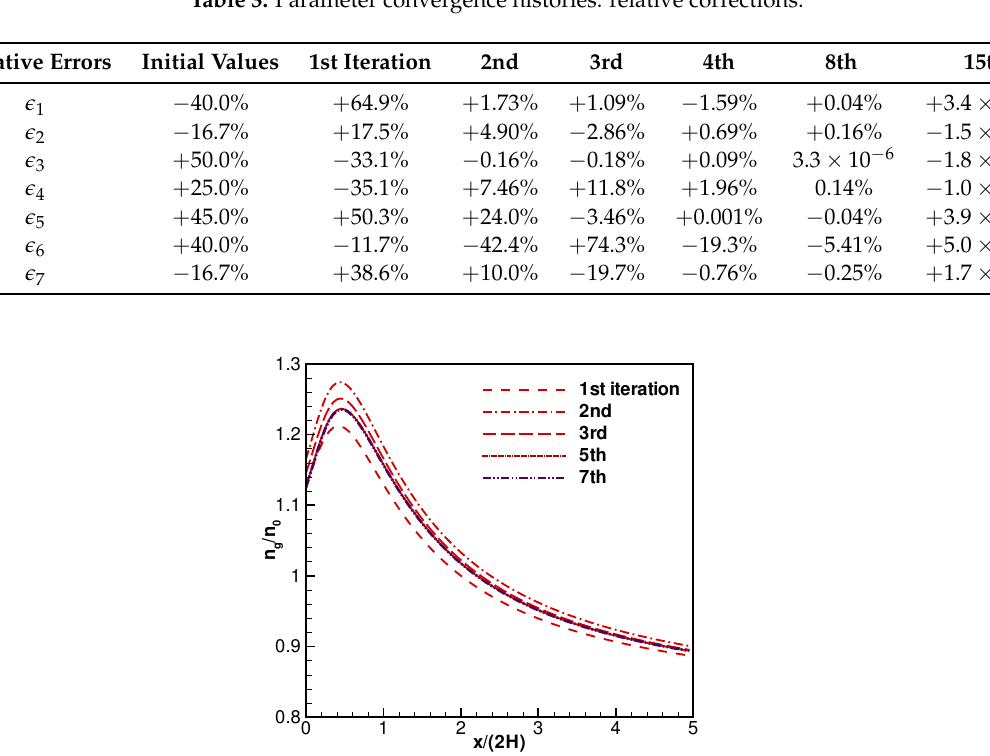
Table 3. Parameter convergence histories: relative corrections.